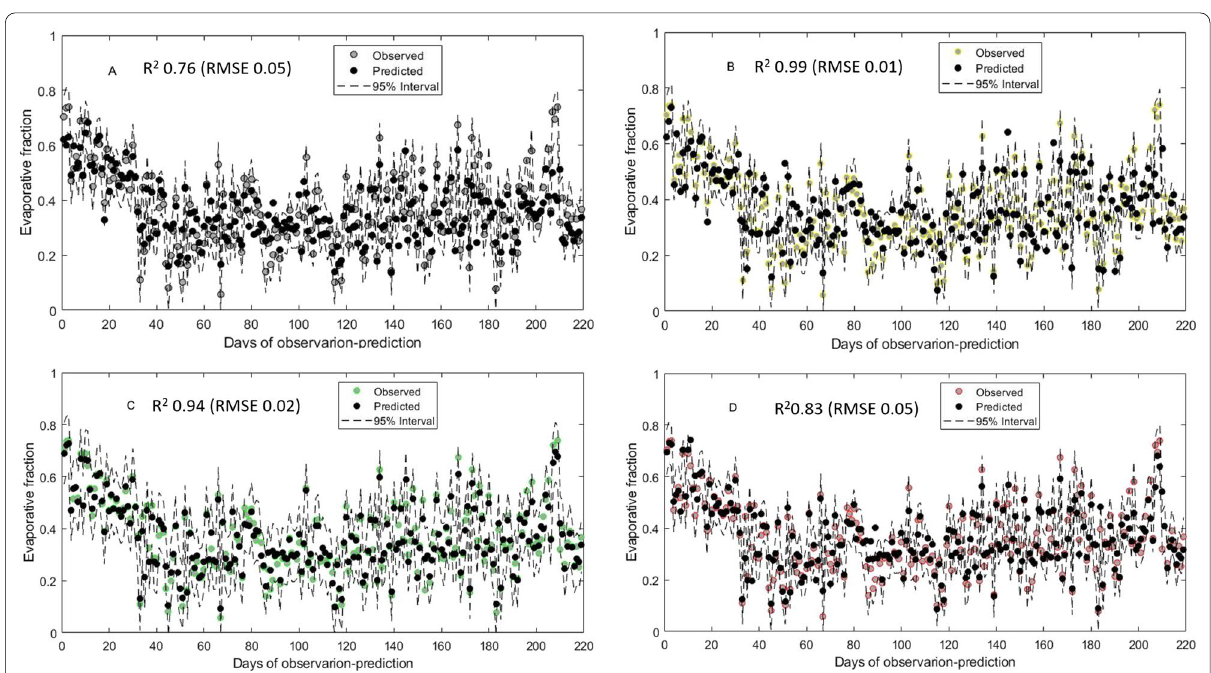
Fig. 4 Comparison between observed and predicted daily EF, during the training phase, of the four different approaches: SVM polynomial model ( A ), GRP rational quadratic ( B ), GRP Matern 5/2 ( C ), and SVM cubic Gaussian ( D ). Colored circles represent the observed values, black circles the predicted values, and the dashed lines represent the 95% confidence